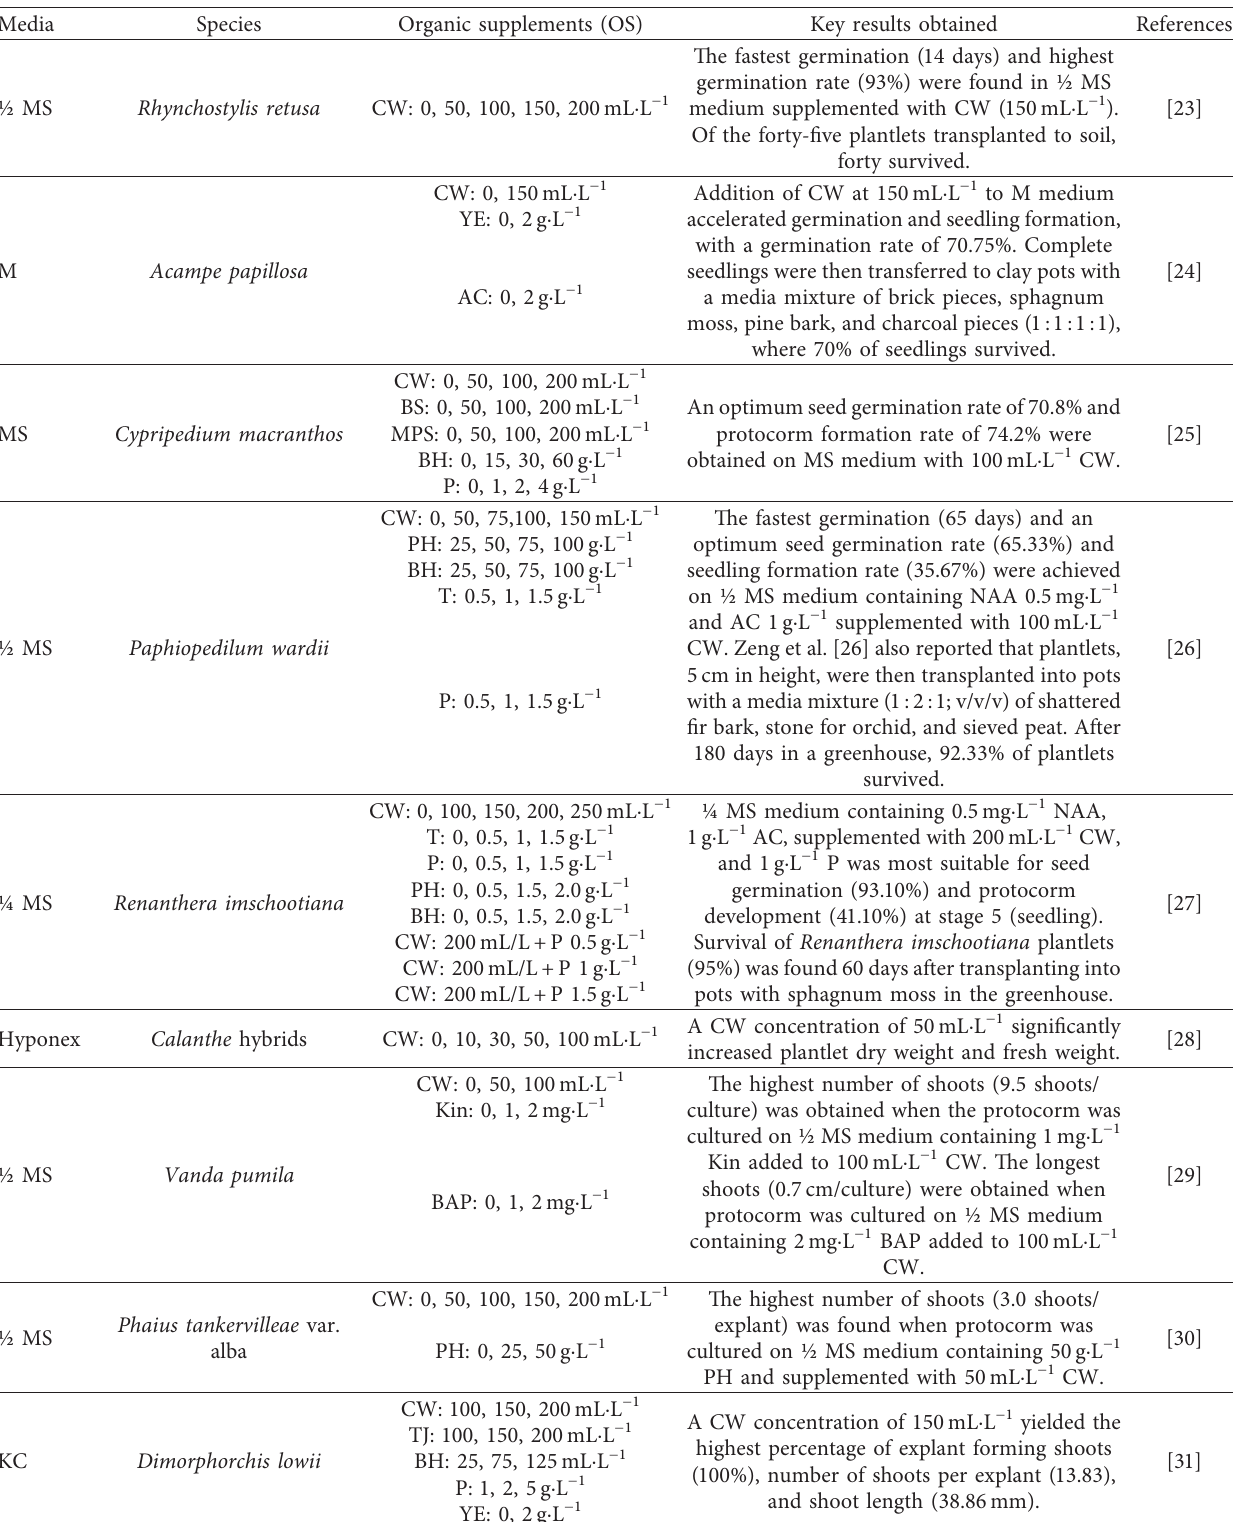
Table 1: Effects of organic supplements on orchid seed germination and protocorm development. Media